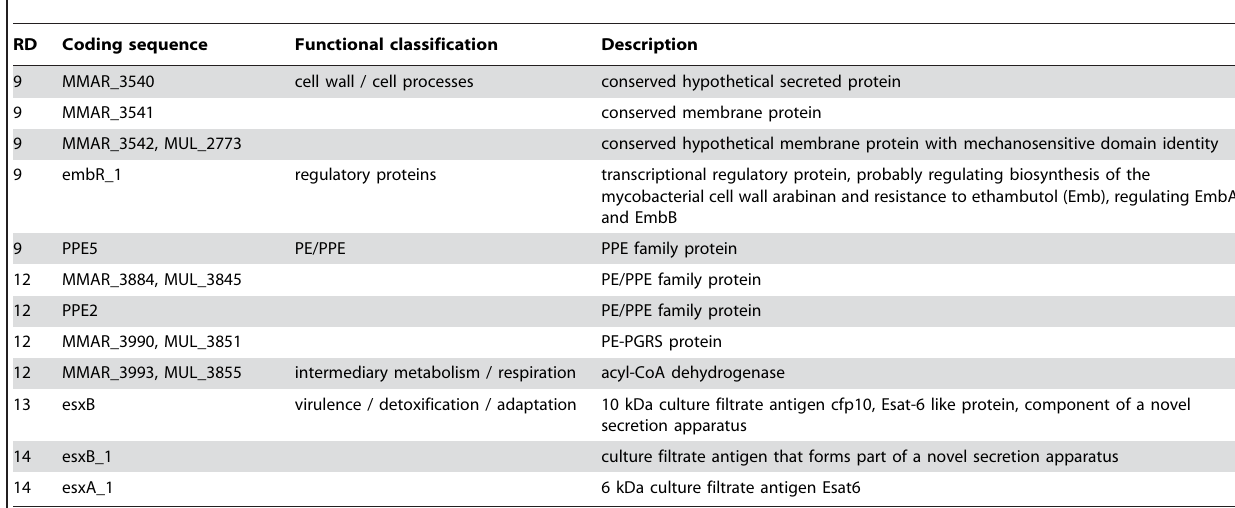
Table 1. CDSs inactivated in at least three independent events in M. ulcerans haplotypes. Indicated are the M. marinum and M. ulcerans